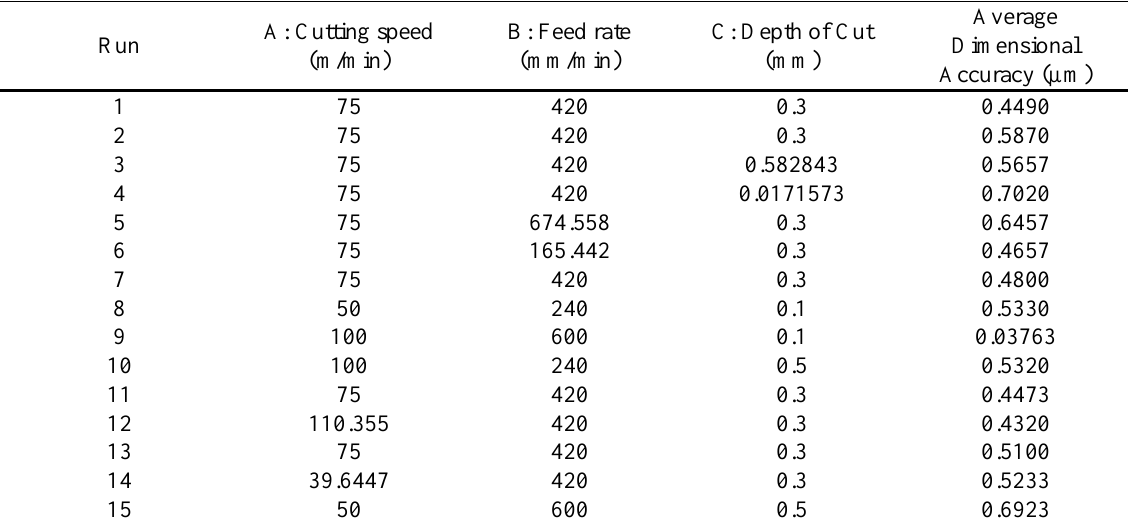
Table 4. Experiment